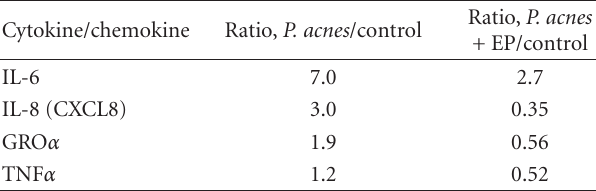
Table 7: EP reversal of P. acnes induced cytokines/chemokines.